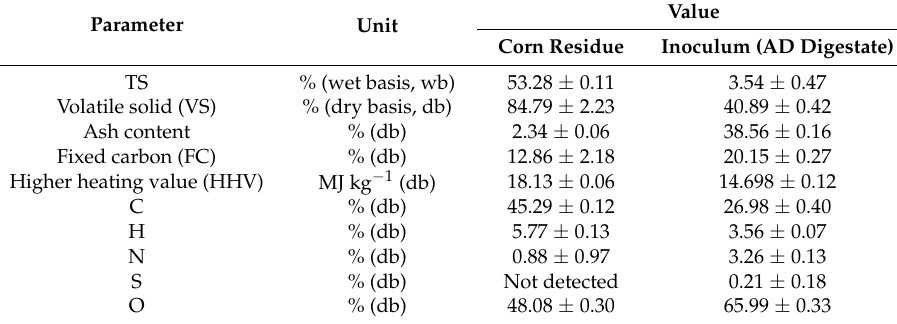
Table 1. Proximate and ultimate analysis of standing plant corn residue and inoculum for